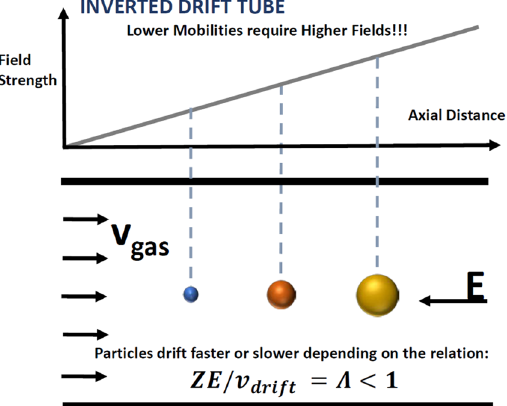
Figure 1. Sketch of the Inverted Drift Tube System. Note the gas flow in the direction of the moving ions and the linearly increasing electric field in the opposite direction.